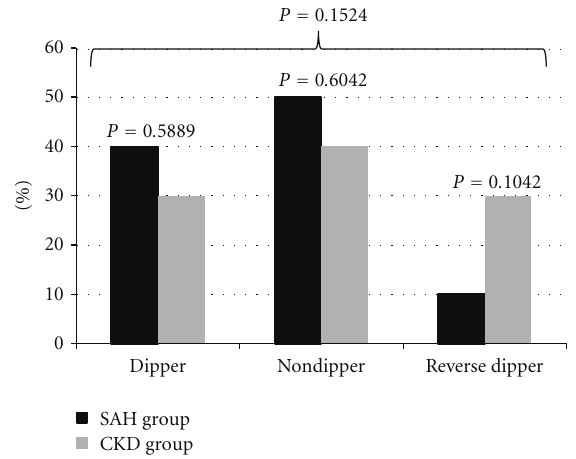
Figure 1: Percentage of nocturnal blood pressure fall patterns as dipper, nondipper, and reverse dipper in chronic kidney disease (CKD) and systemic arterial hypertension (SAH)